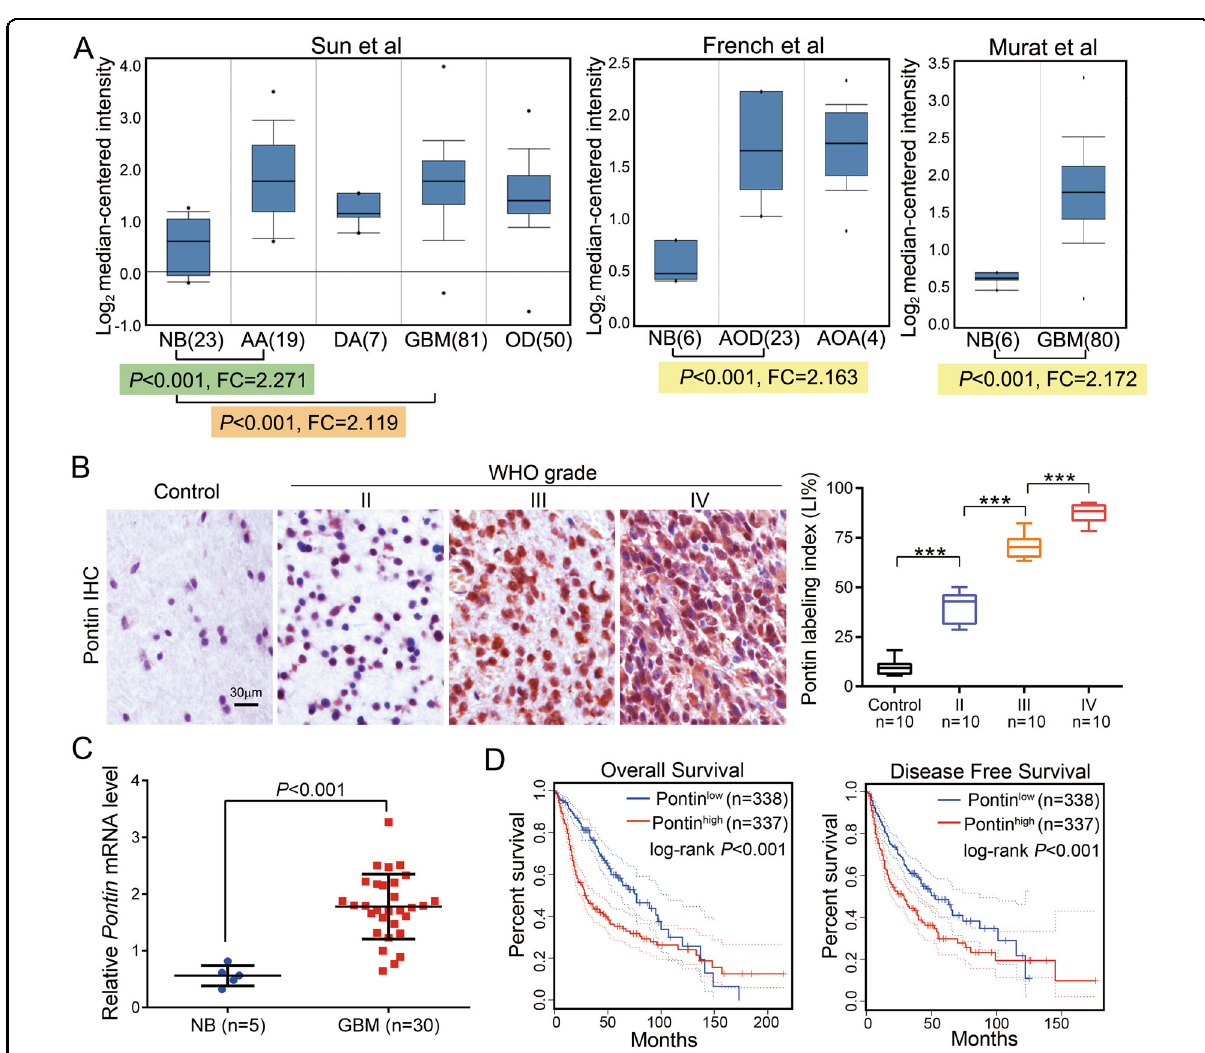
Fig. 1 Increased expression of Pontin in gliomas. A Box plots comparing Pontin mRNA levels between normal brains (NB) and gliomas using the data from Oncomine. Boxes represent the 25th and 75th percentiles, lines represent the median, and whiskers show the minimum and maximum points. Sun et al: NB ( n = 23), anaplastic astrocytoma (AA, n = 19, grade III), diffuse astrocytoma (DA, n = 7, grade II), GBM ( n = 81, grade IV), oligodendroglioma (OD, n = 50, grade II). French et al: NB ( n = 6), anaplastic oligodendroglioma (AOD, n = 23, grade III), anaplastic oligoastrocytoma (AOA, n = 4, grade III). Murat et al: NB ( n = 6), GBM ( n = 80, grade IV). Data are expressed as normalized expression units. FC, fold change. B Representative IHC staining for Pontin in graded gliomas (left) and quanti fi cation of Pontin expression levels [Labeling index (%)] among groups of the FFPE samples (right). Scale bar, 30 μ m. Data are presented as the mean ± SD. C qRT-PCR detection of Pontin mRNA expression in human NBs ( n = 5) and GBMs ( n = 30) collected from our hospital. Data are presented as the mean ± SD. D Kaplan – Meier analyses of the overall survival (left) and disease-free survival (right) of all the glioma patients from the GEPIA dataset. Patients were strati fi ed into high and low expression groups using the median of Pontin expression as